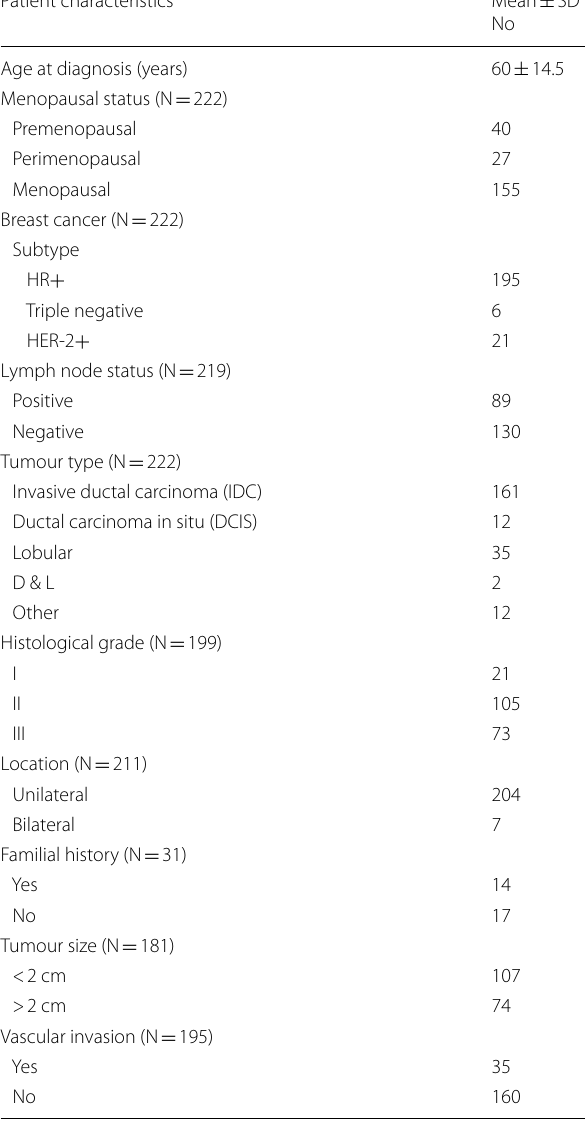
Table 1 Description of phenotypic characteristics of patients Patient